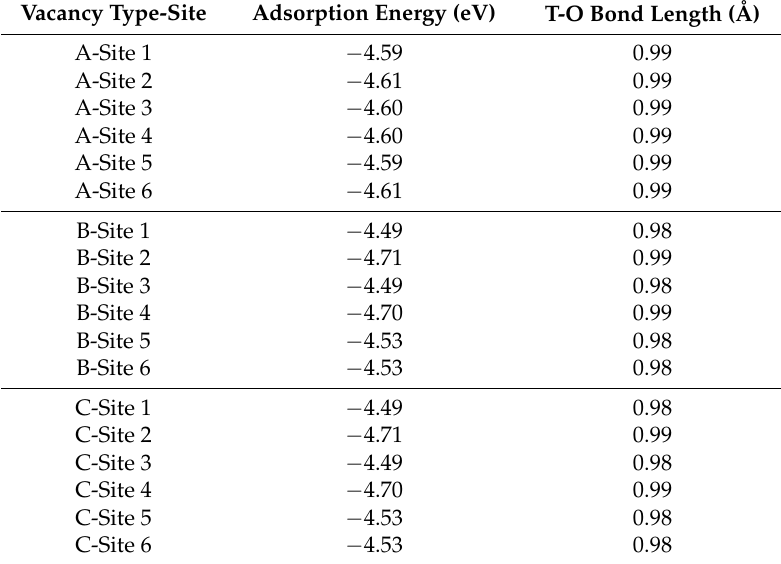
Table 2. Adsorption energy of tritium atom in different sites of three types of Li